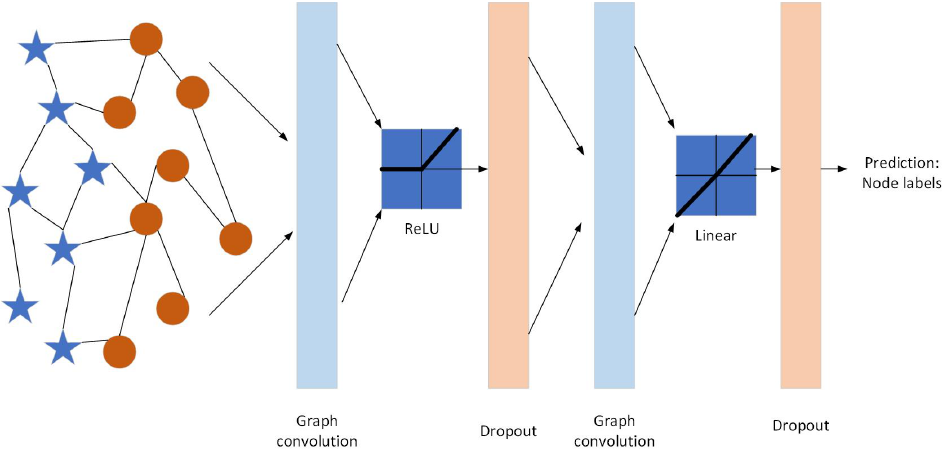
Figure 2. Schematic of Cert